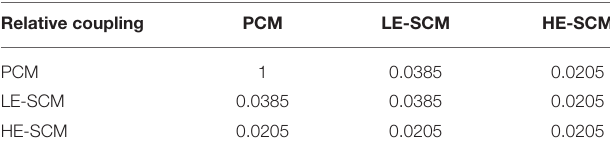
TABLE 2 | Intercellular gap junctional coupling levels in the computer model. Relative coupling PCM